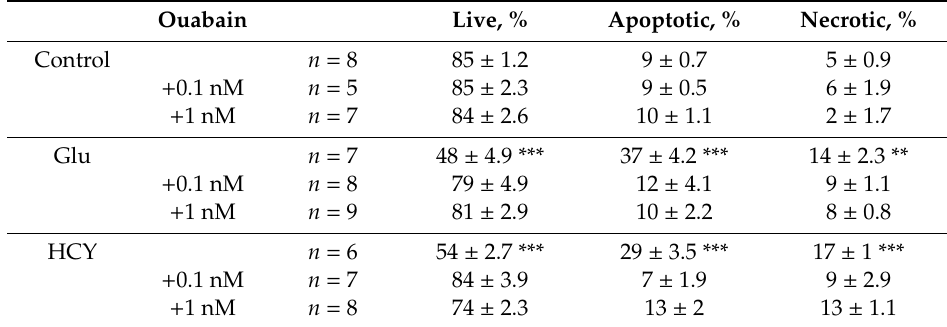
Table 1. The neuroprotective e ff ect of ouabain against neurotoxicity induced by 4 h glutamate (Glu) or homocysteine (HCY) treatment of rat cortical neurons.